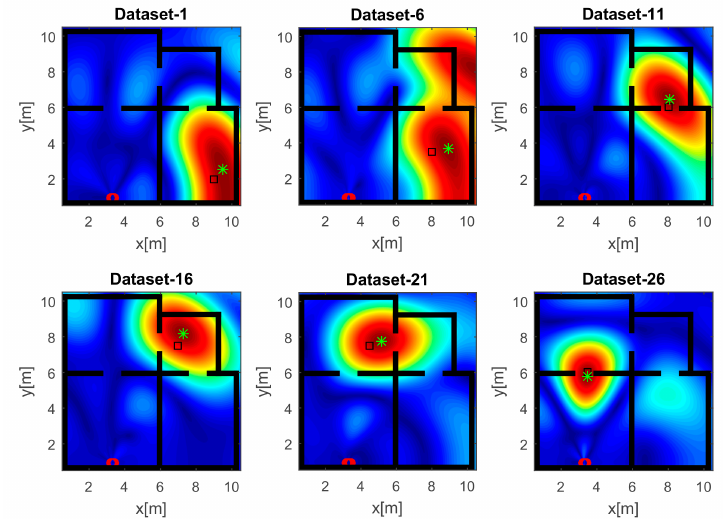
Figure 6. Tomographic images of a narrow band source achieved with the horizontal array (A). Array (red circles); true source position (black square); estimated source position (green asterisk). Color scale is [0,